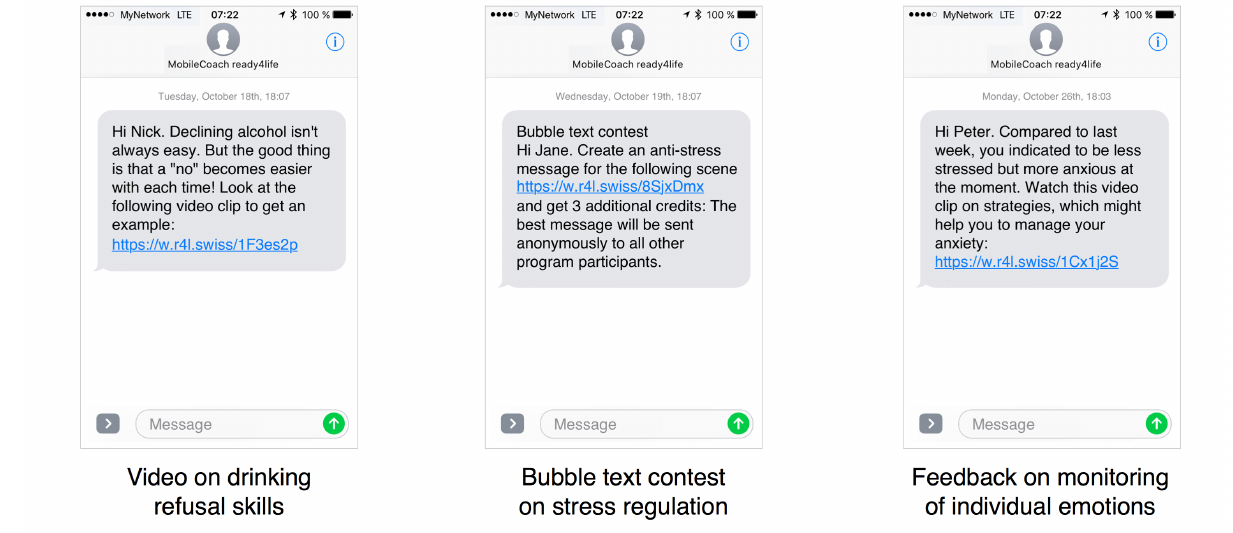
Figure 1. Sample messages (translated from the German program version).